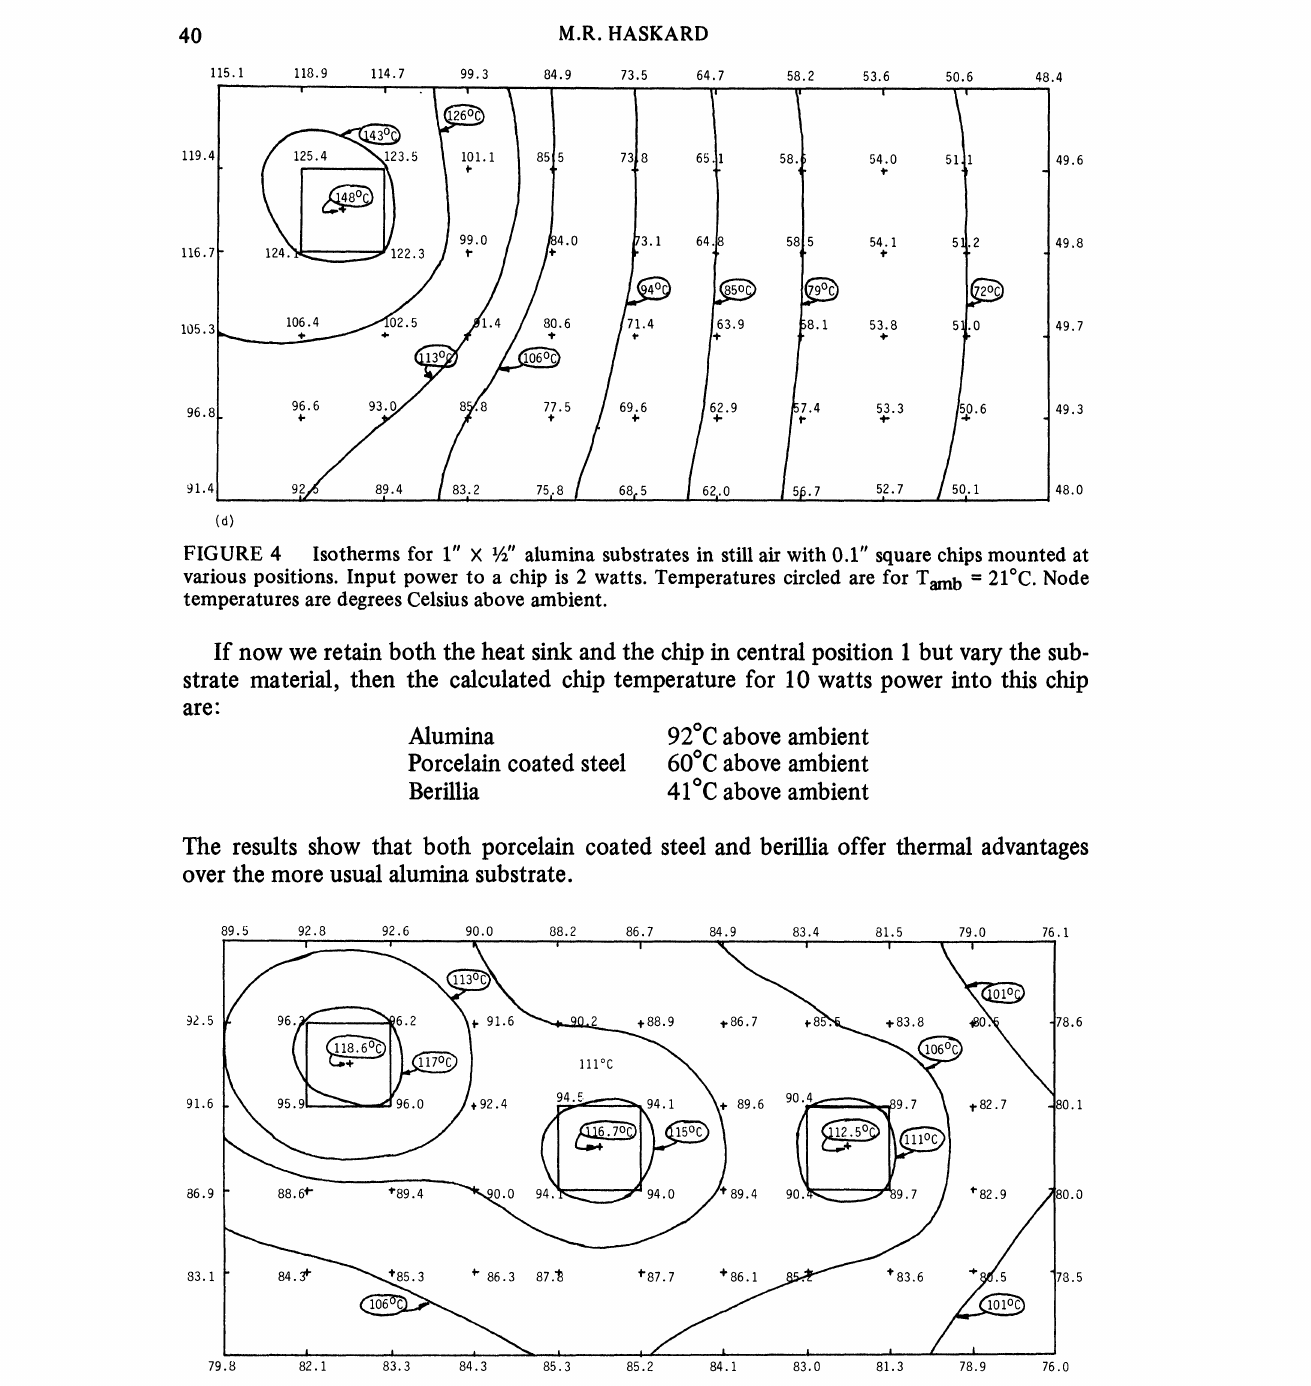
FIGURE 5 Isotherms and node tempexatttres fox three chips each dissipating 3/4 watts mounted on an alumina substrate 1" X 1/2". Temperatures circled are for Tam b 21C. Node temperatures are degrees Celsius above